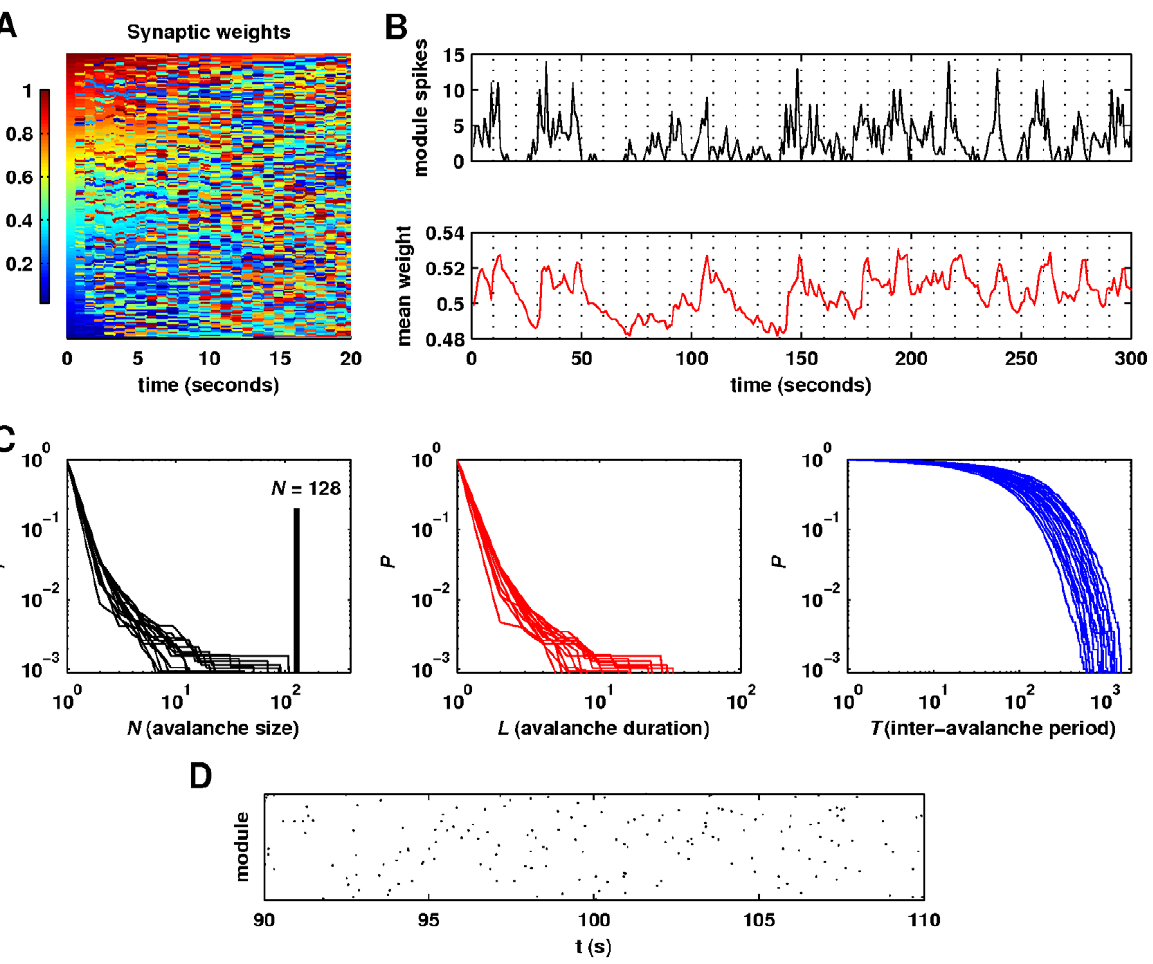
Figure 5. Relationship between spike-timing-dependent synaptic plasticity and network dynamics. (a) Fluctuations of within-module synaptic weights over a 20 second period. Synaptic weights were rank-ordered and assigned a rank-specific color at the first sampled time step. At subsequent steps, weights were re-ranked and therefore reordered, but the color-coding remained fixed. The mixing of colors hence represents fluctuations in rank positions. Stable synaptic weight distributions allowed the inference of weight fluctuations from these rank fluctuations. Weights were sampled at 50 ms intervals. (b) Illustrative fluctuations in the number of module spikes (top) and in the mean within-module excitatory synaptic weights (bottom), recorded over a 5 minute period from a single module. Module spikes were binned at 1 second intervals, and synaptic weights were sampled at 1 second intervals. (c) Cumulative probability distributions of avalanche sizes, avalanche durations and inter-avalanche intervals and (d) an illustrative module spike raster of dynamics emergent on nonhierarchical network topologies in Figure 4a, with frozen synaptic